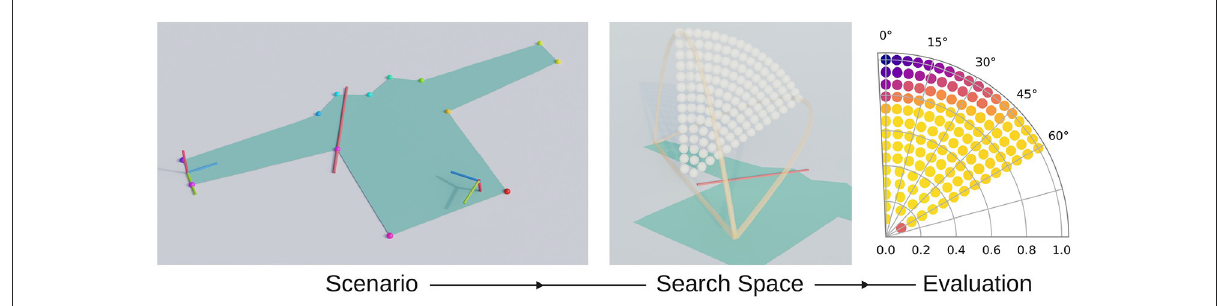
FIGURE2 Method overview: a selected scenario (left) for which a search space is automatically set up (middle) and which is subsequently evaluated (right) .